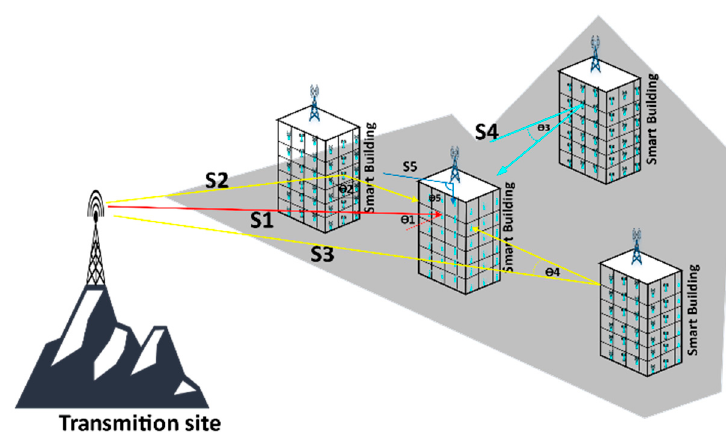
Figure 3. The five-ray model used to calculate the indoor power level. It defines two direct rays (S1 and S5) and three reflected rays (S2, S3, and S4).